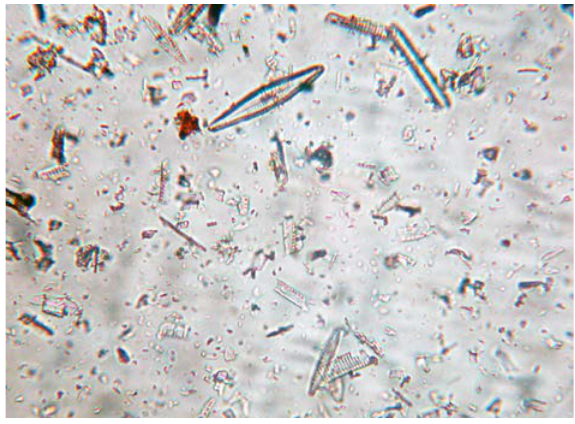
Figure 3. Diatomite used as a substrate for an orange organic dye in a 1st Century AD pigment from Pompeii.